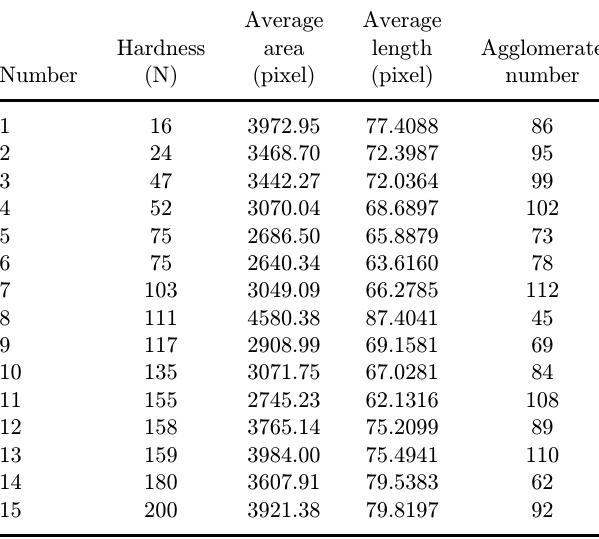
Table 1. Assemessment parameters of PVPP distrbution in Yinhuang dispersible tablets.